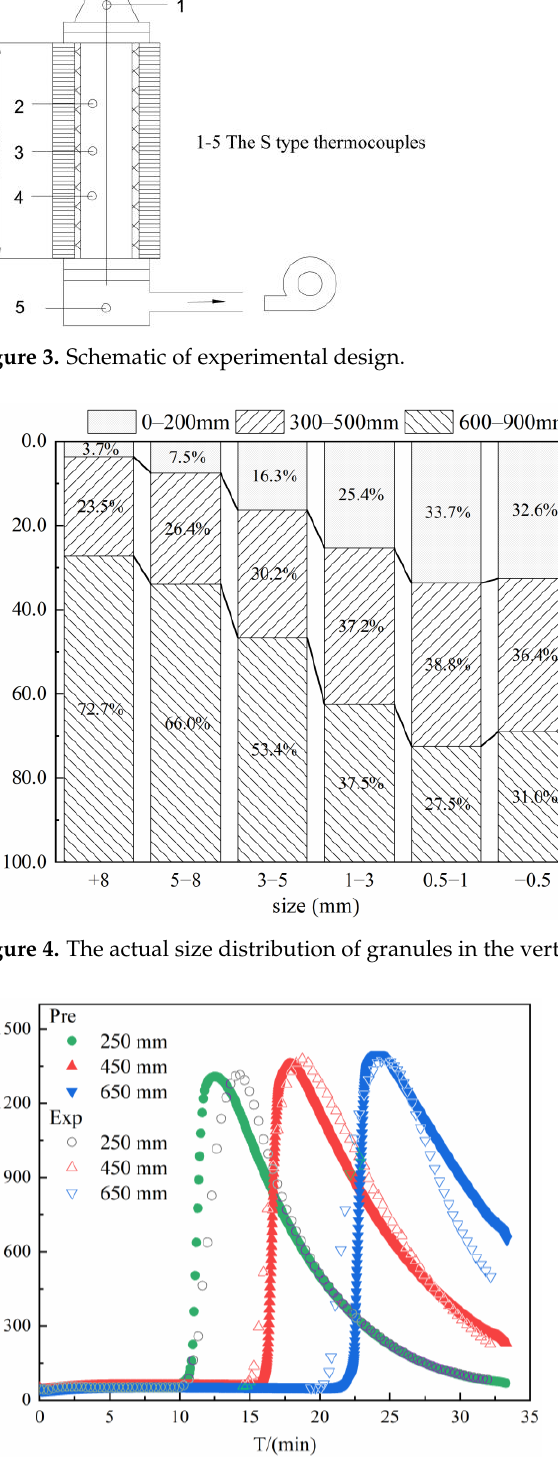
Figure 5. The comparison of the simulation and experiment of the temperature.